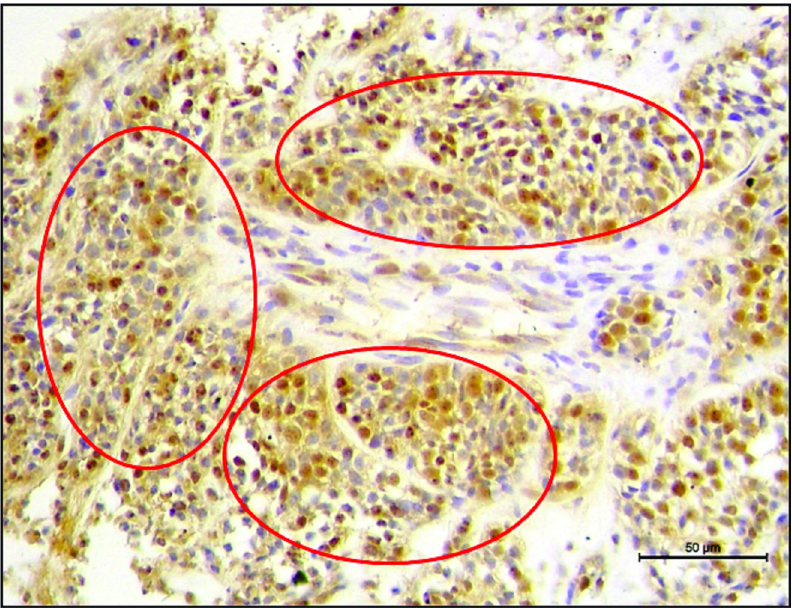
Fig 6. Photomicrography of immunohistochemical analysis. Circles indicate foci of tumor cells with positive cytoplasmic and nuclear expression of FAS-L in the mammary carcinomas of female dogs.